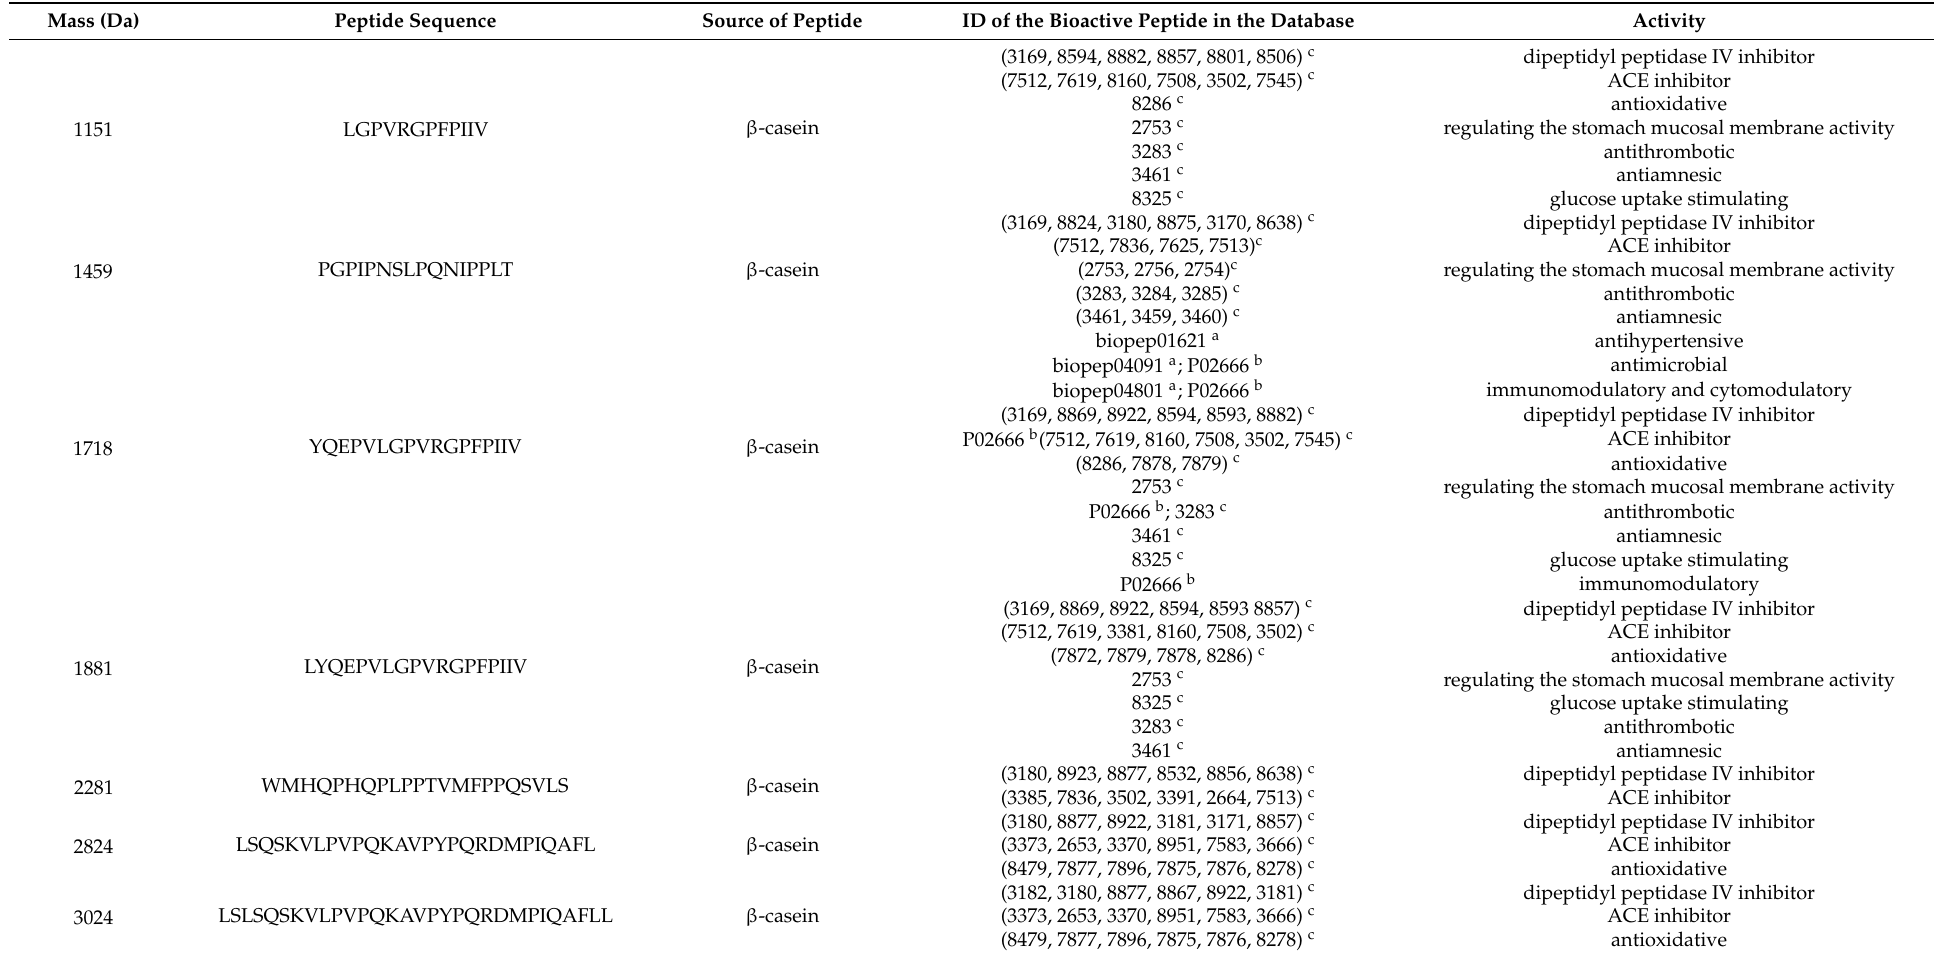
Table 1. Assigned peptide sequences by RapidDeNovo